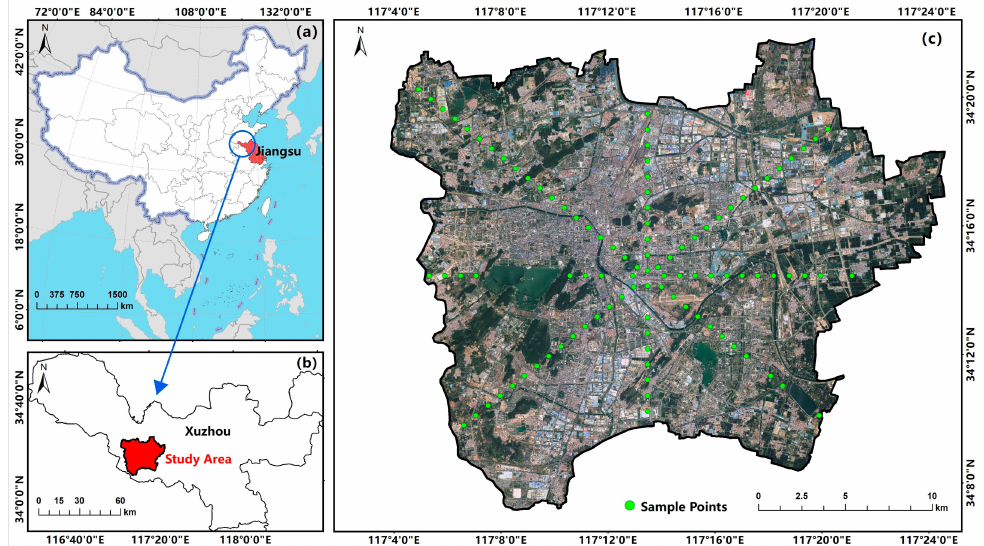
Figure 2. Location and satellite image of the study area. ( a ) Map of Jiangsu Province in China; ( b ) map of the study area in Xuzhou; and ( c ) GF-1 satellite image of the study area on 28 April